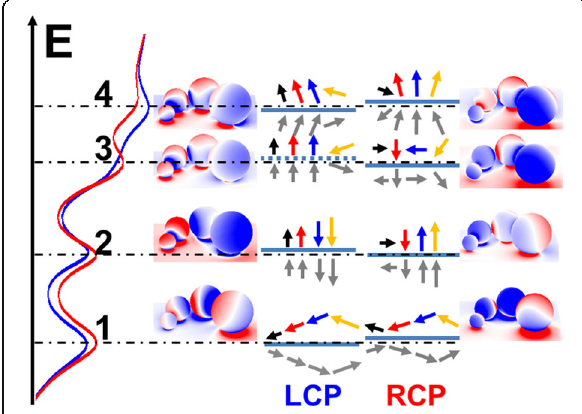
Fig. 3 Scheme of the hybridization of the chiral particle-film system. The blue and red solid curves on the left are the reflectance spectra for the system excited by LCP and RCP, respectively. The surface charge distributions of the chiral particle chain and the gold film for LCP or RCP light are shown on left and right sides. The color arrows indicate the polarization states of the different radius particles, which are 20, 30, 40, and 50 nm for the black, red, blue, and yellow. The horizontal dashed lines from up to down represent the energy levels of the peaks at 590, 635, 710, and 785 nm, respectively